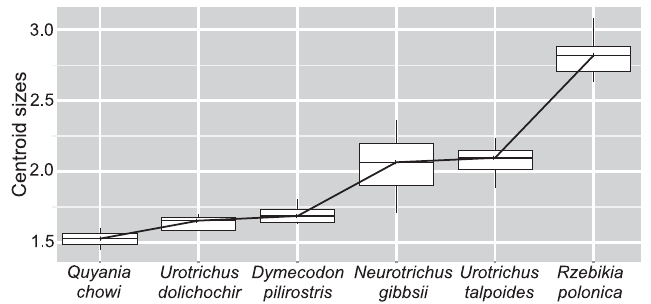
Fig. 4. Boxplot of the centroid sizes. Bottom and top of the boxes are the first and third quartiles, the horizontal black lines represent the median, the whiskers represent the minimum and maximum